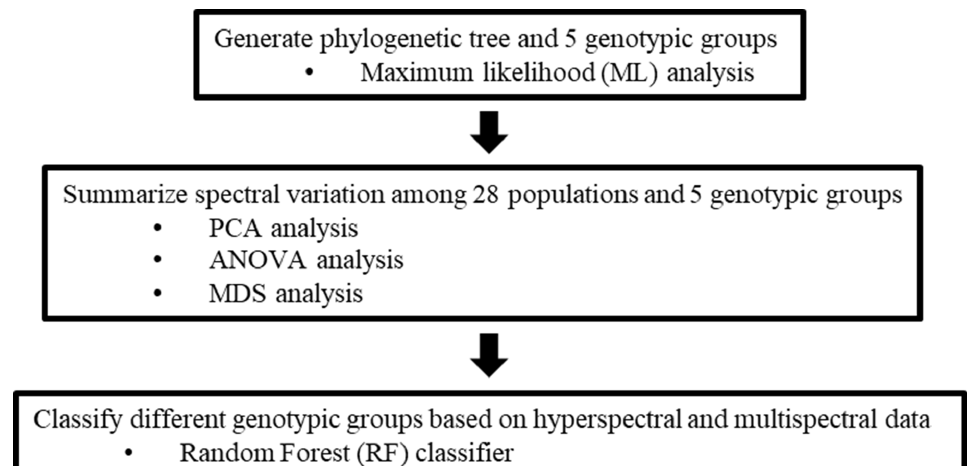
Figure 2. The workflow for analyzing spectral variation and evaluating the genotypic